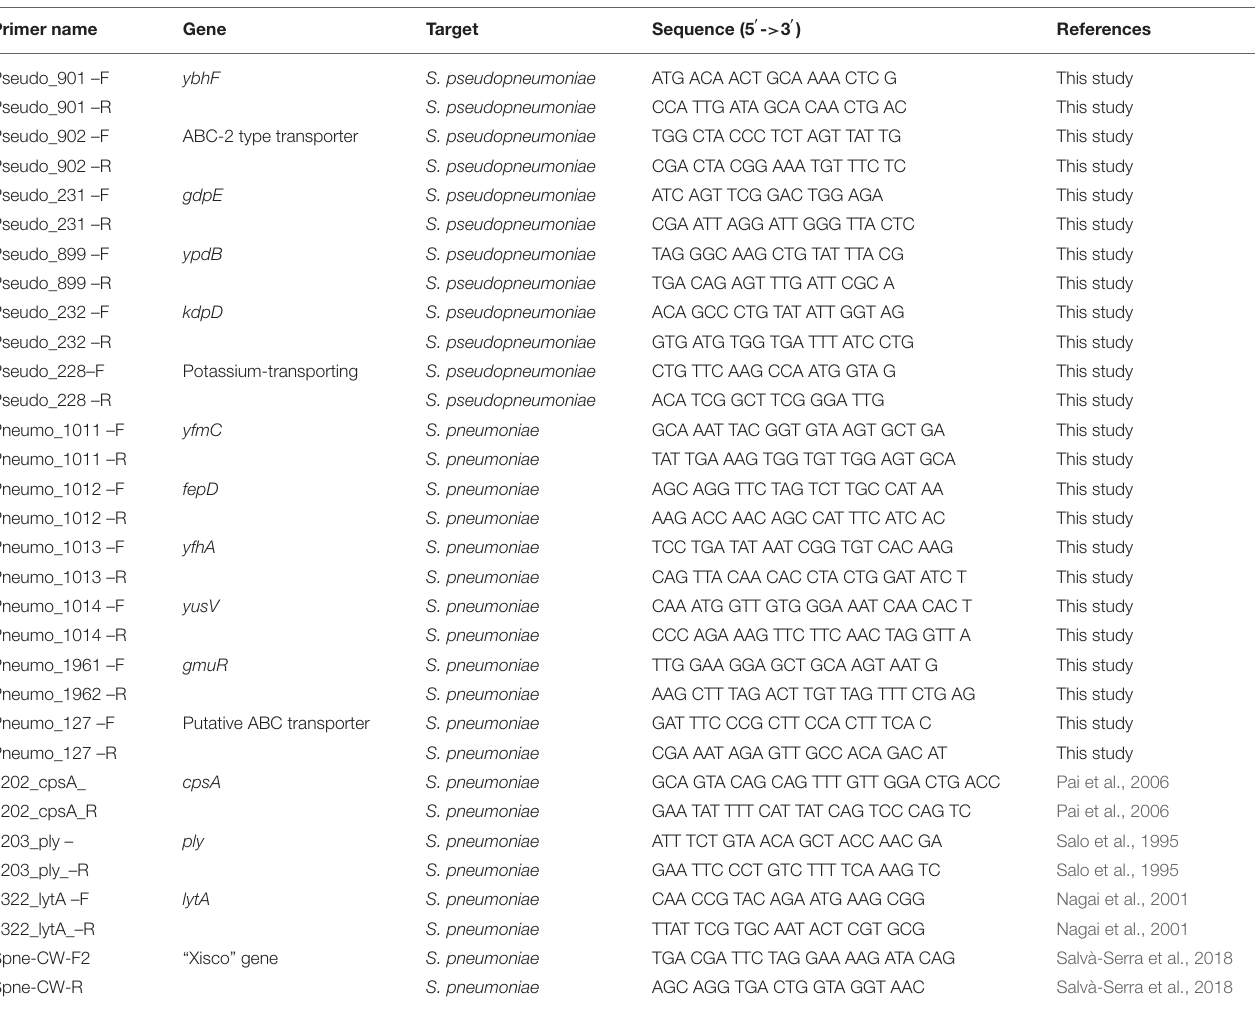
TABLE 1 | List of PCR-primers used for amplification of unique gene markers of S. pneumonia e and S. pseudopneumoniae